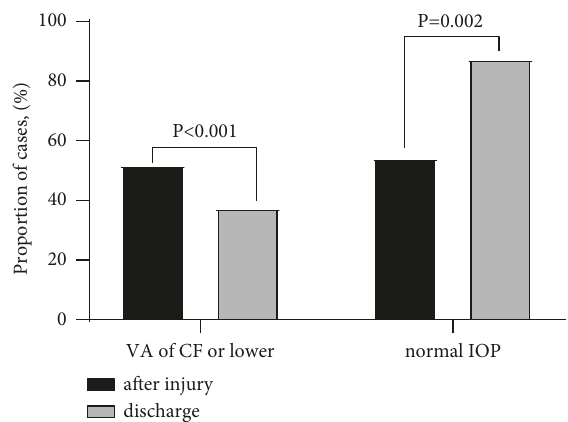
Figure 4: Comparison of visual acuity and intraocular pressure between after injury and discharge in the children with exact